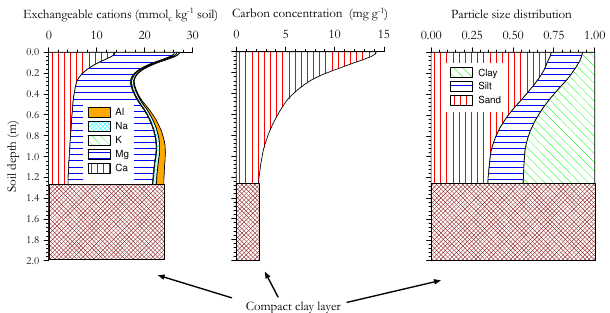
Fig. 12. Profiles of exchangeable cations, soil carbon and texture Fig. 12 for a Cutanic Lixisol (Ferric, Hypereutric) in Venezuela